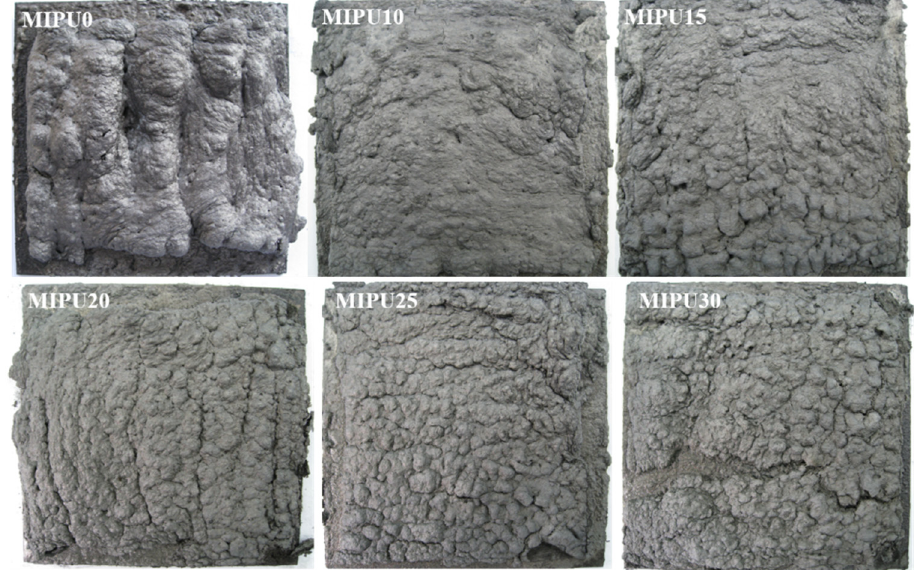
Figure 6. Macro top views of the expanded char of the coatings.